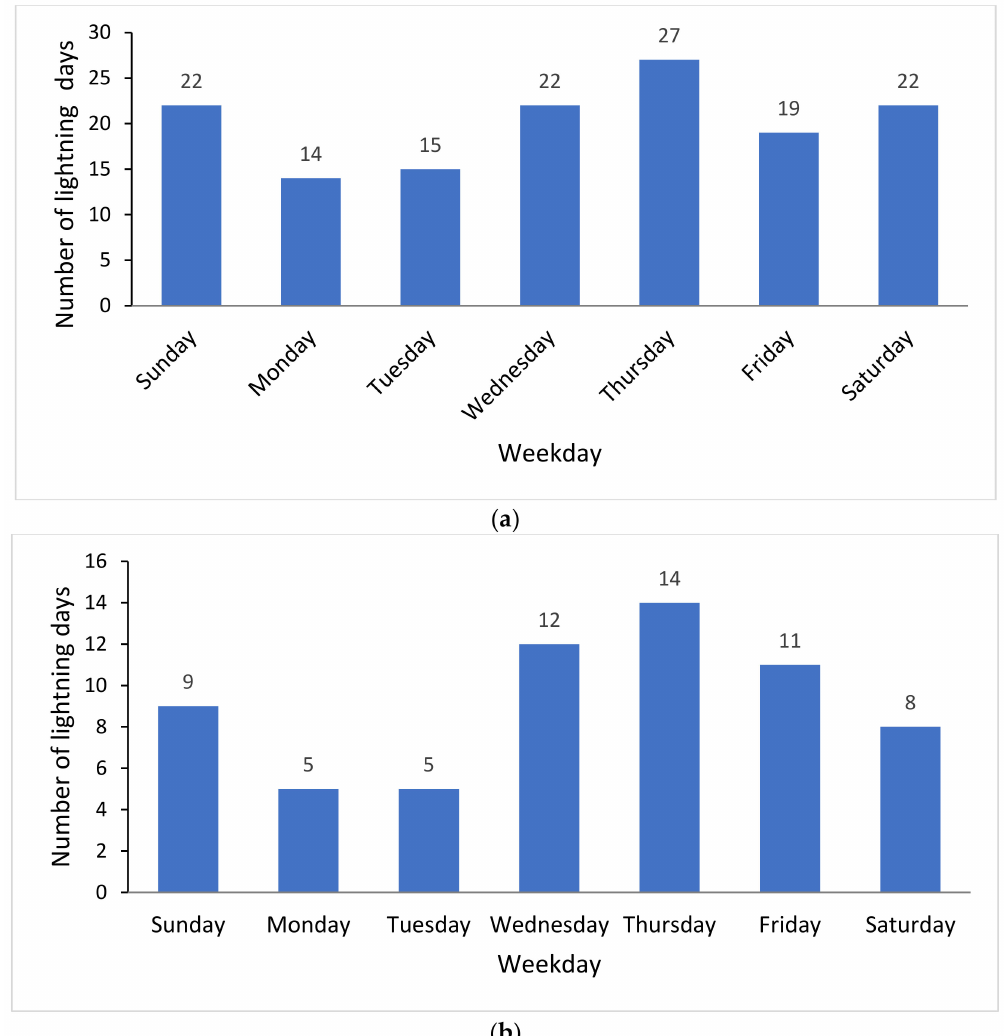
Figure 3. ( a ) Weekly distribution of lightning days for the 9 DJF s of the study period, based on 9 winter seasons of ILDN data. ( b ) Weekly distribution of lightning days for the 5 DJF seasons of 2017/18 and 2021/2022, based on ENTLN data. The lower numbers reflect the shorter period. Interestingly, the fraction of +CG from the total (percentage) was largest on Sunday and Wednesday, 9.2% and 7.7%, respectively, with a minimum fraction on Friday of 4.5%. The fraction of +CG from the total number of cloud-to-ground strokes in Israel is known to depend on the meteorological conditions [18,19], which differ from month to month, and is highest in December and lowest in January, most likely related to the intensity of wind shear in winter thunderstorms [20]. When looking at the average values of the peak-current for the strokes detected above the Tel-Aviv Metropolitan Area, +CGs are stronger (42 kA) than -CG (15 kA), but no weekly pattern is discernable. This difference in the average current intensity is in line with findings from other places, as reported in [21]. The spatial distribution of lightning within the study area for DJF based on ENTLN data are shown in Figure 5. The coastline is denoted as a black line (north is up). There are clear maxima over the urban area of the greater Tel-Aviv area, with three distinct enhancements located over Jaffa and the Holon-Bat-Yam area, just south of the city center. This offset can be attributed to the interaction between the south-westerly flow from the Mediterranean Sea and the built area, which leads to an enhanced friction and induced